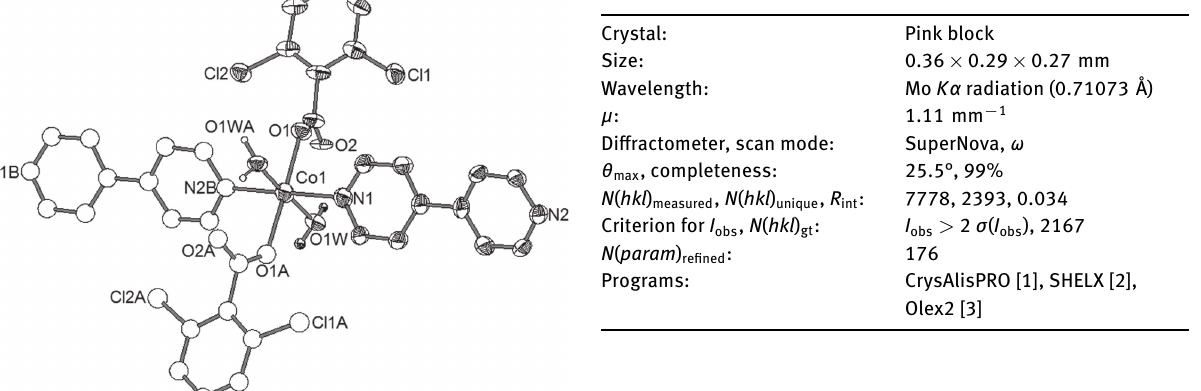
Table 1: Data collection and